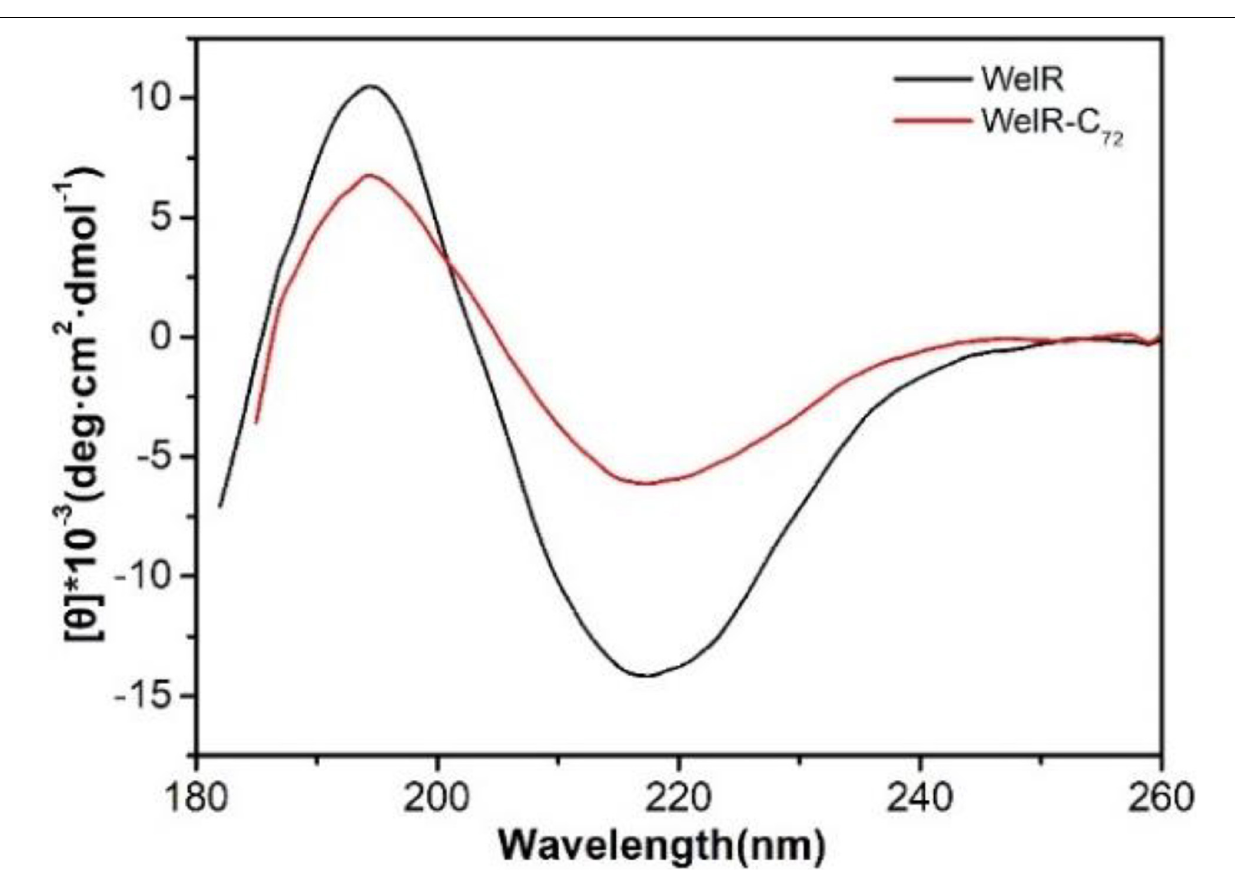
Frontiers in Microbiology |